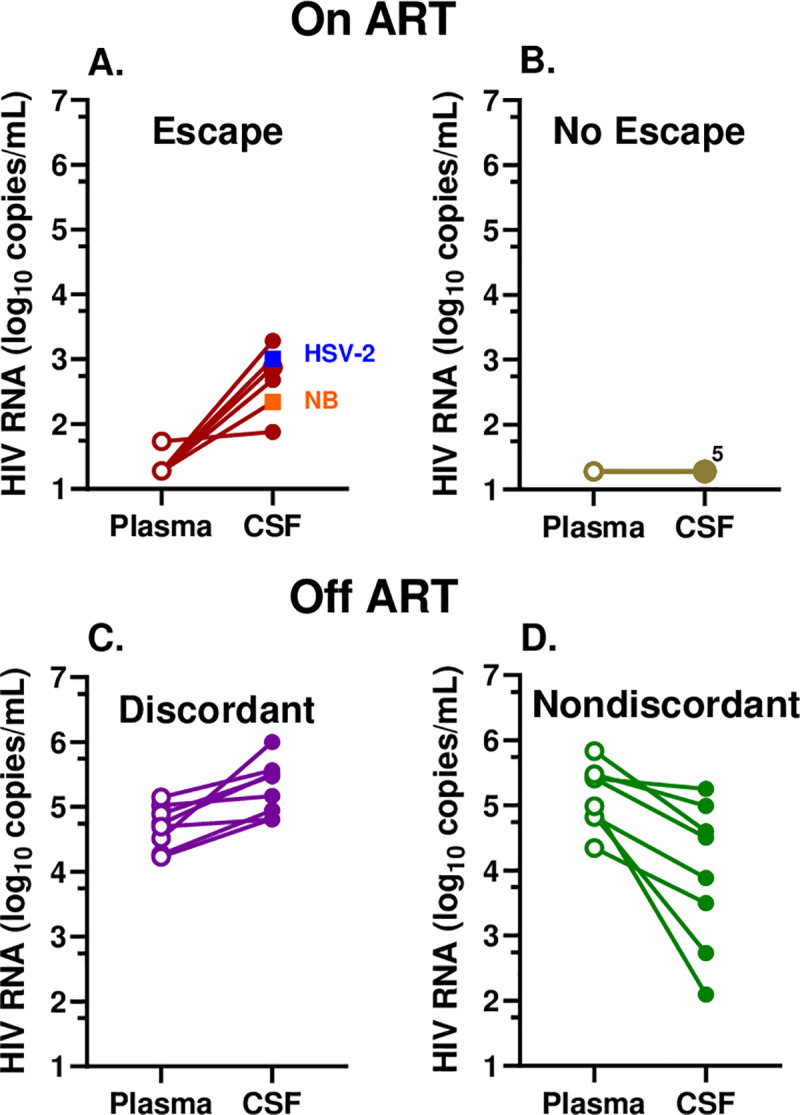
Relation between plasma and CSF HIV-1 RNA concentrations in the 4 subject subgroups.A. Treated CSF escape group including the 4 HZ (brown circles) and two other infections—neuroborreliosis, NB (orange) and HSV-2 encephalitis (blue); B. Treated, no escape, 5 HZ with overlapping CSF HIV-1 RNA levels at the LLoQ (pale green); C. Untreated CSF discordant (purple); and D. Untreated CSF nondiscordant group (dark green). Plasma values are represented by open symbols and CSF with solid symbols and lines connect plasma and CSF from the same individual.